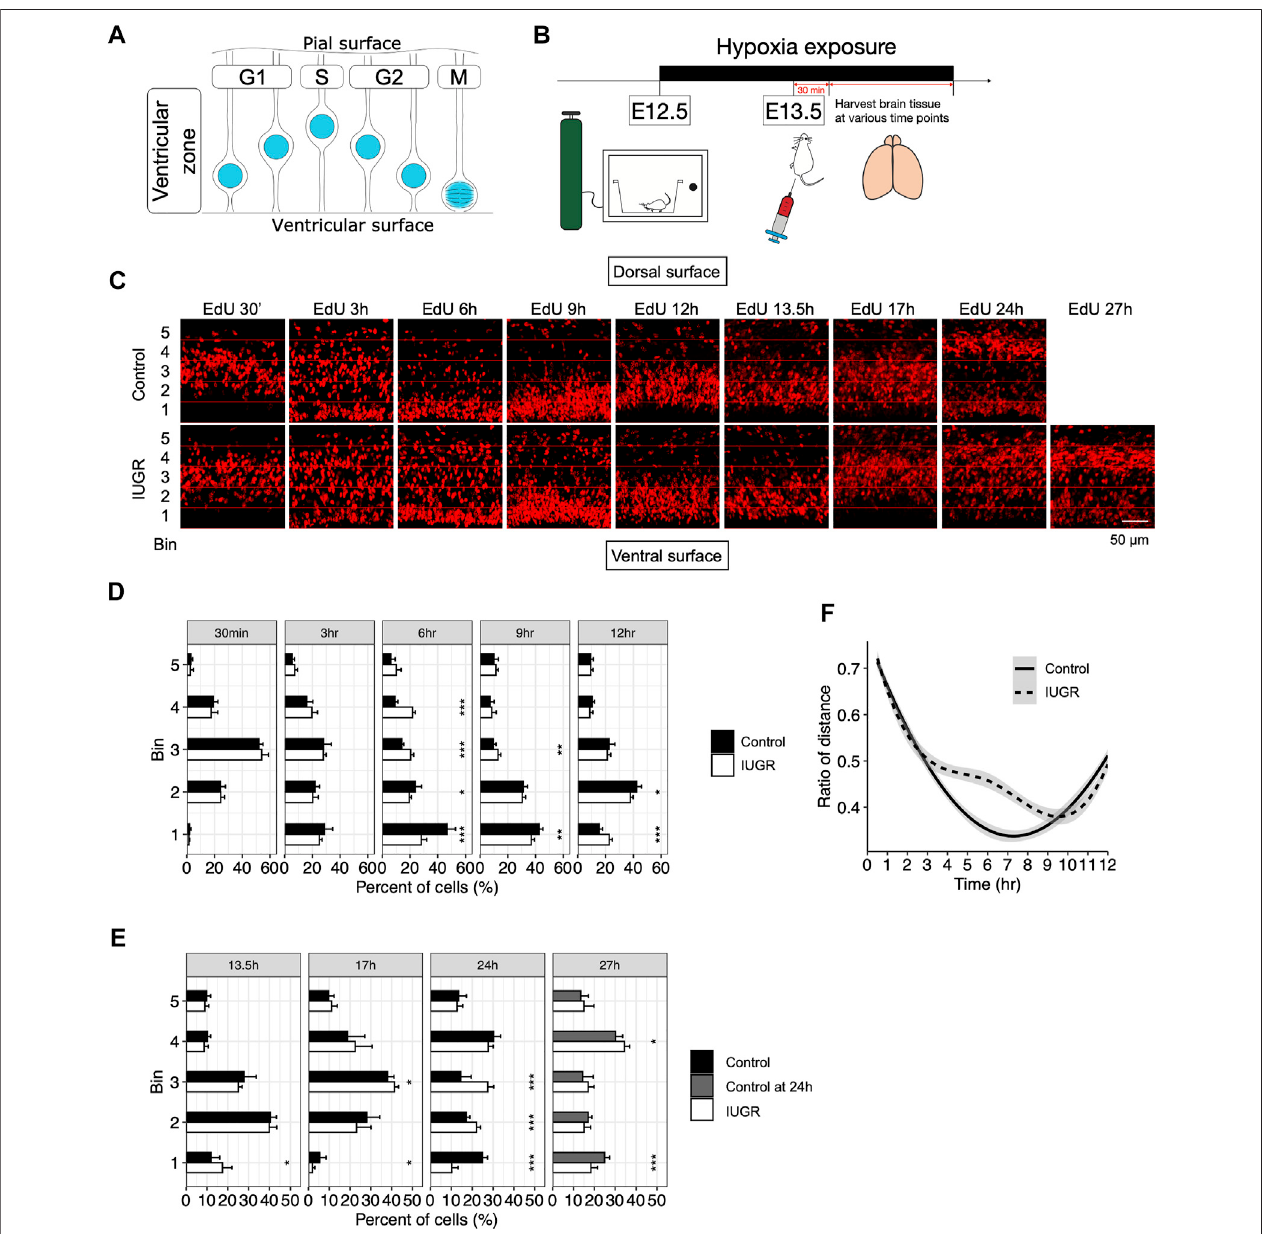
FIGURE 3 | Delayed cell cycle progression of fetal neural stem/progenitor cells in the intrauterine growth restriction (IUGR) mouse fetal brain. (A) Schematic representation of the coupling of interkinetic nuclear migration and cell cycle stages. (B) Schematic representation of the experimental design. (C) EdU staining at indicated time points. Horizontal lines represent boundaries of the bins used for quanti fi cation in panels D – F. (D,E) Quanti fi cations of the cells in panel C showing the proportion(shownaspercentage)ofbin-speci fi cEdU(+)celldensitytototalEdU(+)celldensityperview.Notethatthebarsinthecontrolgroupforthe27 hplotare the same as those in the 24 h plot. (F) Modeling of the distance between the nuclei to the ventricular lining over time in the control and the IUGR group.